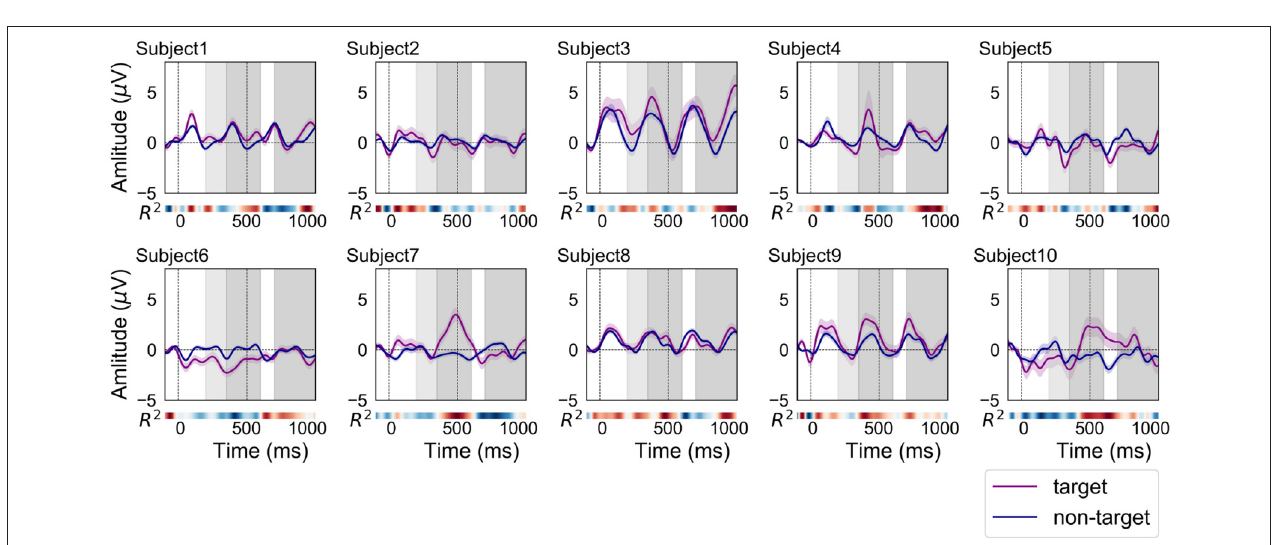
FIGURE 3 | ERP and non-ERP waveforms of each subject in the offline analysis (purple line: ERP, blue line: non-ERP). The filled fields along the plots denote the standard error (SE) of amplitudes for each time point. The time interval for N200 is filled with light-gray color at 200–350 ms. In addition, the time intervals between 350–600 and 700–1,000 ms were filled with dark-gray color for finding the positive peaks of ERP responses.